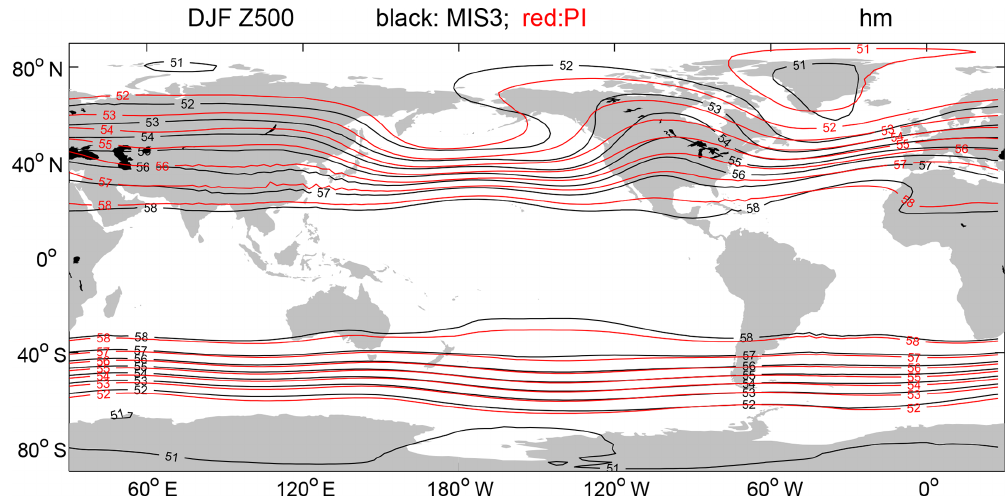
Figure 5. Simulated MIS3 and PI DJF 500mbar geopotential height (hm). The black and red contours are for the MIS3 and PI experiments, respectively.